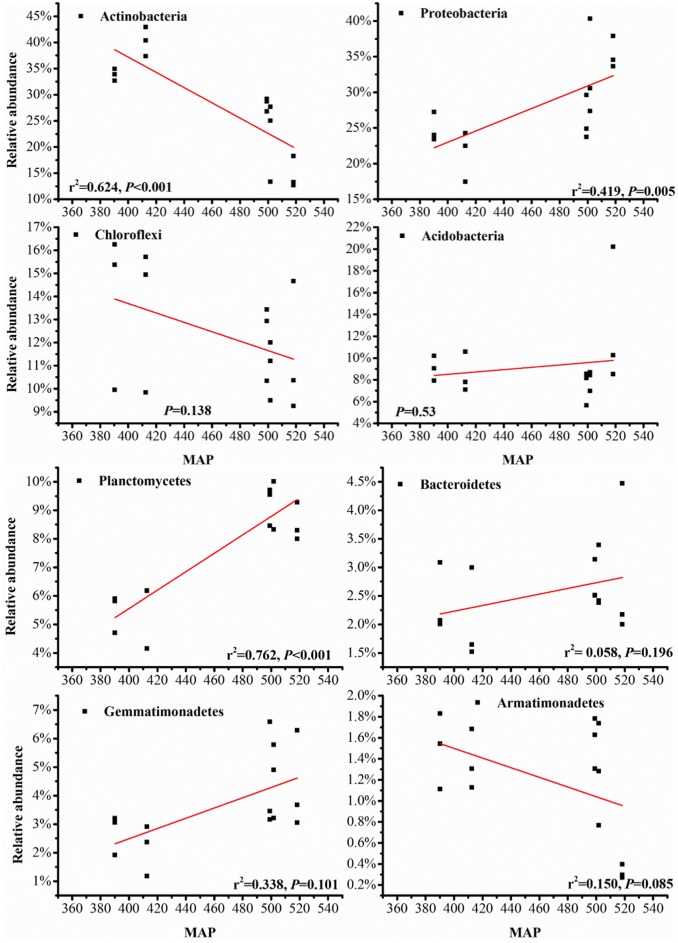
Ordination plots of the results from the RDA to examine the relationship between bacterial populations (shown in the blue) and selected environment factors (shown in red), including pH, TP, TN, MAP, MAT, MBC, SOM, SM and C/P in the five different ecosystems.Site 1, 2 and 3 were in the desert ecosystem; Site 4, 5 and 6 were in the sandy ecosystem; site 7, 8 and 9 were in the grass ecosystem; site 10, 11 and 12 were in the forest- grass ecosystem; site 13, 14 and 15 were in the forest ecosystem.